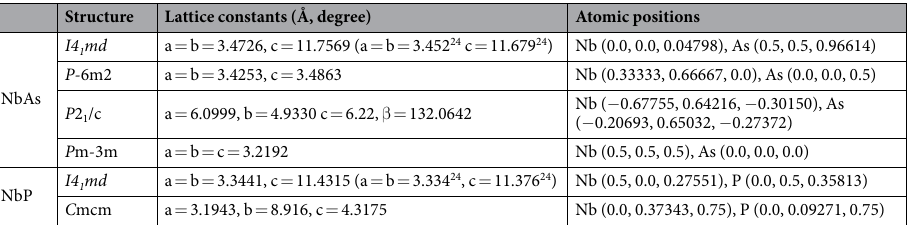
Structure Lattice constants (Å, degree)